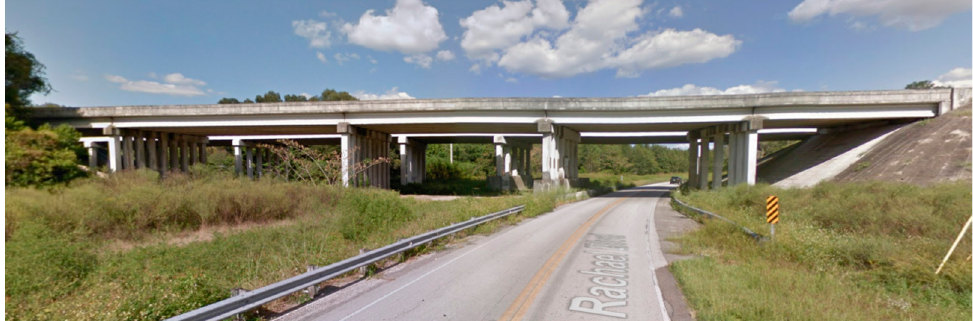
Figure 7. Google Maps Street View of the bridge used for development of UAS system.